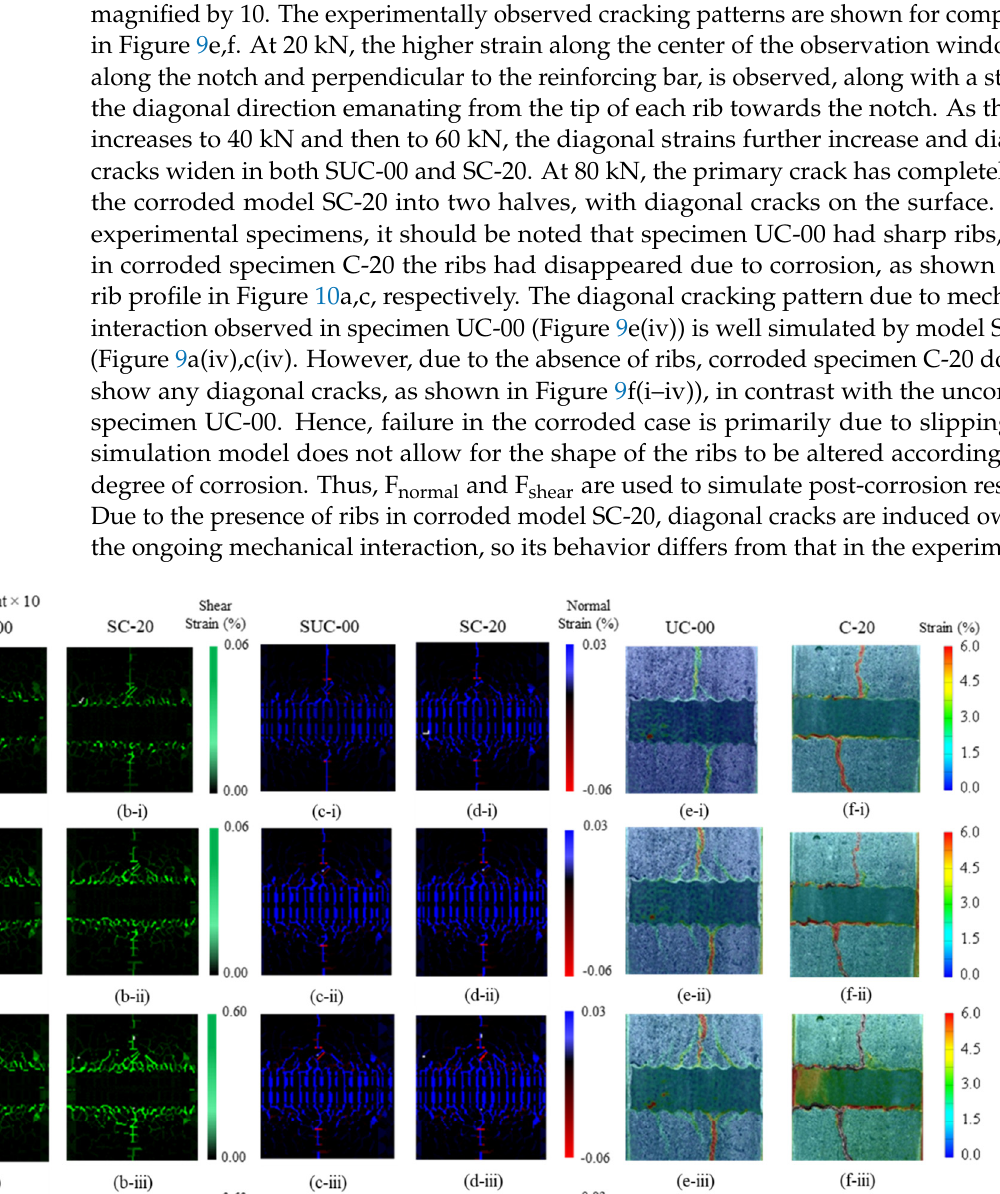
Figure 10. Observed final cracking pattern in: ( a ) uncorroded case in experiment; ( b ) uncorroded case in simulation; ( c ) corroded case in experiment; and ( d ) corroded case in simulation.